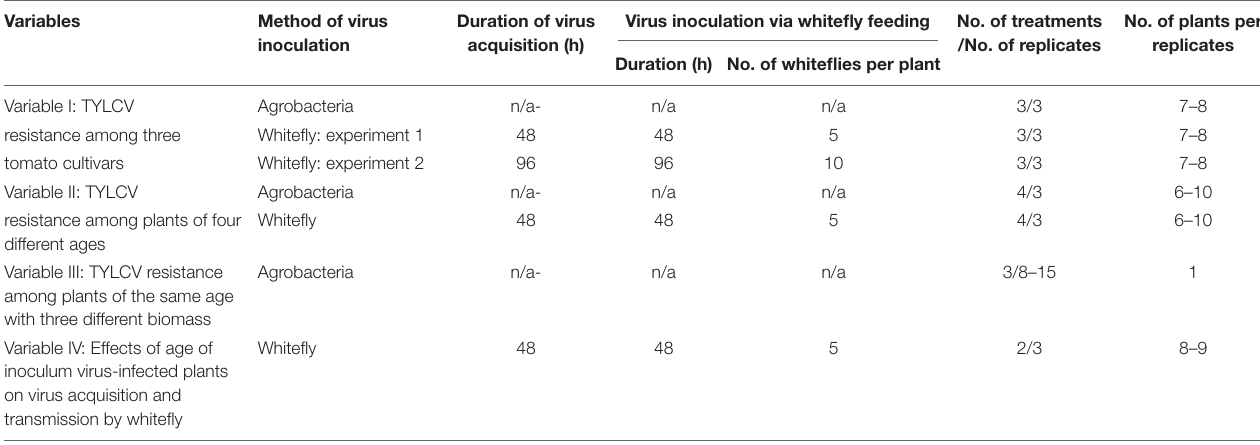
TABLE 1 | Variables tested in experiments for comparing resistance to Tomato yellow leaf curl virus (TYLCV) among tomato plants of different cultivars, of the same cultivar with different ages and of the same age with different biomass as well as for examining the effects of age of inoculum virus-infected plants on virus acquisition and transmission by